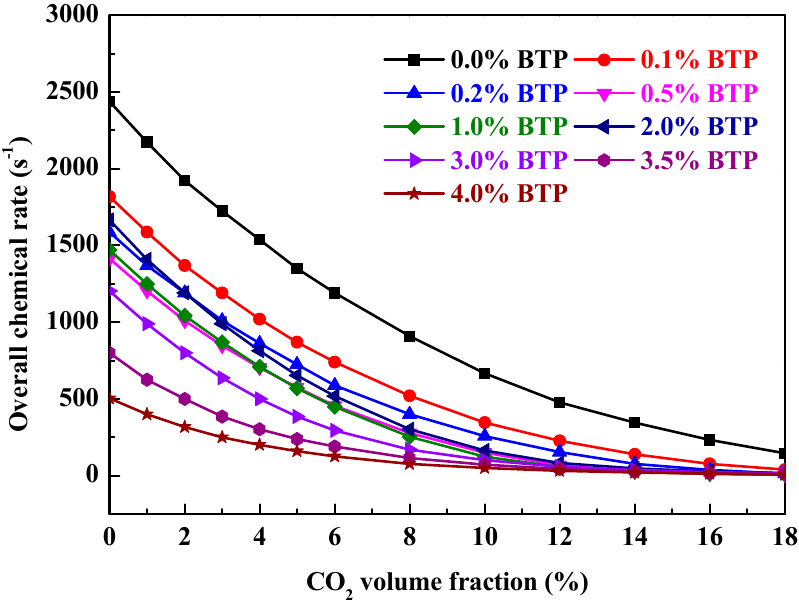
Figure 5. The dependence of overall chemical rates on CO 2 volume fraction with a fixed 2-BTP adding to moist C 3 H 8 /air flames at 298 K and 1 bar.